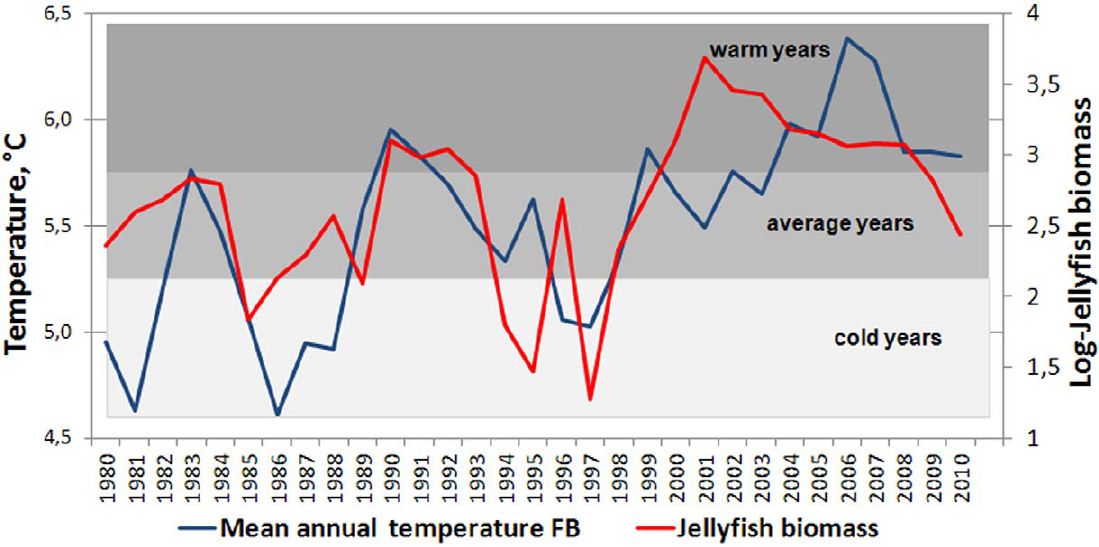
Figure 3. The mean annual water temperature at the Fugløya-Bear Island section (left axis) and the log transformed jellyfish biomass indices (right axis).